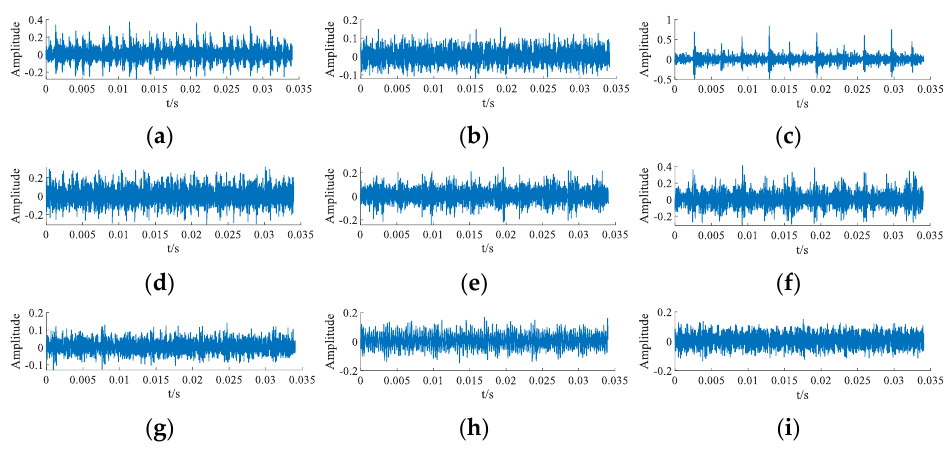
Figure 4. The original vibration signal of rolling bearings: ( a ) The original vibration signal of OR_07. ( b ) The original vibration signal of OR_14. ( c ) The original vibration signal of OR_21. ( d ) The original vibration signal of IR_07. ( e ) The original vibration signal of IR_14. ( f ) The original vibration signal of IR_21. ( g ) The original vibration signal of B_07. ( h ) The original vibration signal of B_14. ( i ) The original vibration signal of B_21.